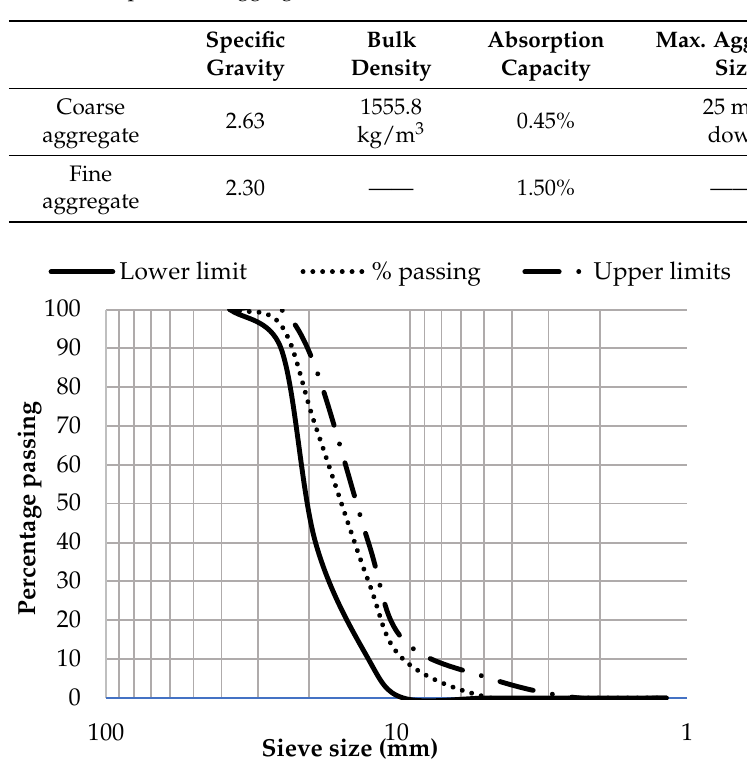
Table 2. Properties of aggregate.